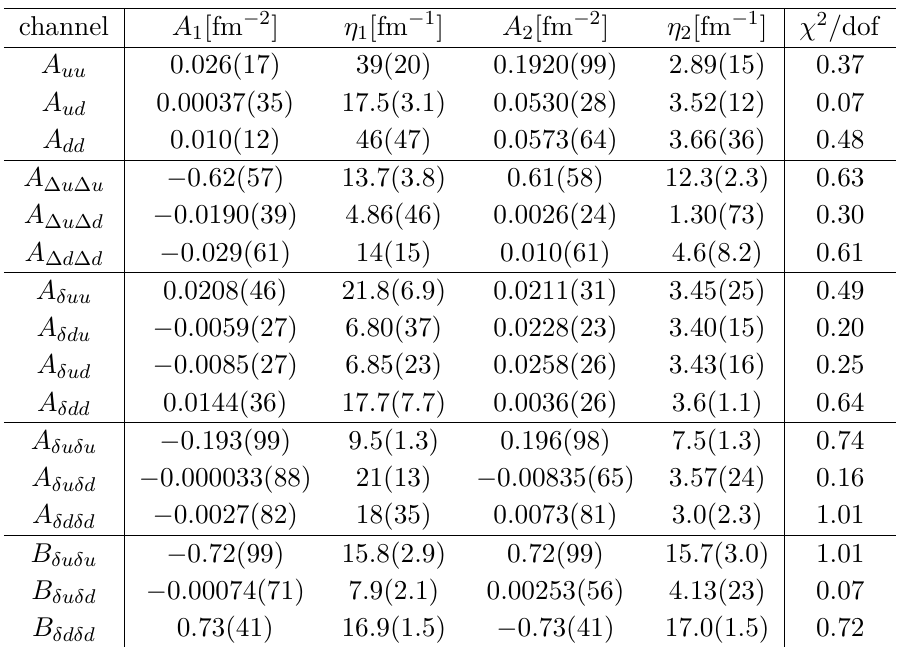
Table 6 . Results of the fit (4.2) to the twist-two functions at py = 0 . The corresponding χ 2 / dof is listed in the rightmost